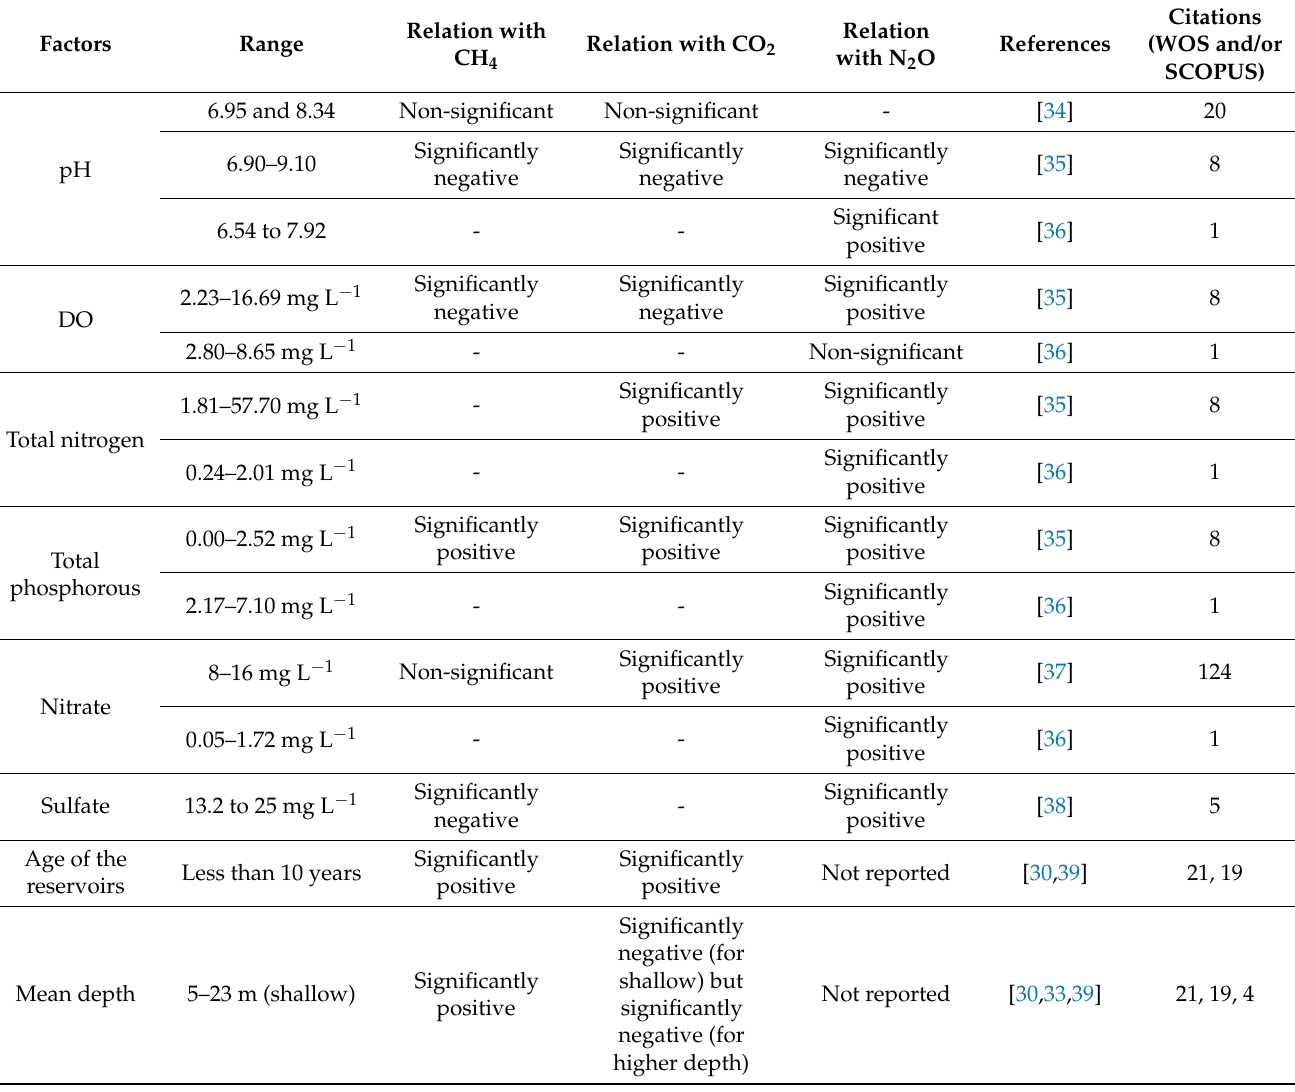
Table 2. Some important factors and their relationship with GHGs from water